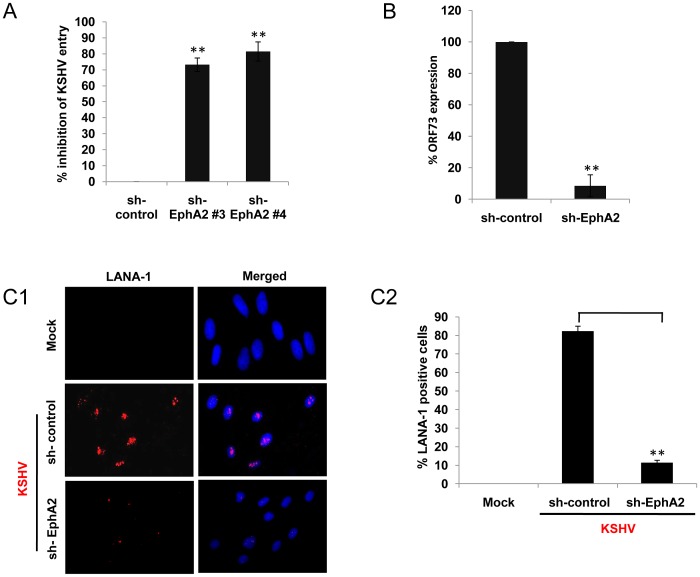
Effect of EphA2 knockdown on KSHV entry and infection in HFF cells.(A) Control or different EphA2 shRNA-transduced HFF cells were infected with KSHV (30 DNA copies/cell) for 10 min at 37°C. After washing, total DNA was isolated and virus entry was determined by real-time DNA PCR for KSHV ORF73 gene. Results are presented as percentage of inhibition of KSHV DNA internalization by sh-EphA2 transduced compared to control shRNA transduced HFF cells incubated with virus. Data shown are means ± SD (n = 3; ** statistical significance, P<0.01). (B) Control or sh-EphA2 transduced (no 4) HFF cells were infected with KSHV for 2 h. At 48 h.p.i., cells were harvested for RNA isolation and viral gene expression was determined by real-time RT-PCR with KSHV ORF73 gene specific primers. Data represented are means ± SD (n = 3; P<0.01). (C1 and C2) Control or sh-EphA2 transduced HFF cells were either mock infected or infected with KSHV (30 DNA copies/cell) for 2 h at 37°C, washed and cultured in complete media for another 46 h. After washing, cells were fixed and processed for immunofluorescence using rabbit anti-LANA-1 antibody. Representative images are shown. The percentage of cells showing punctate LANA -1 dots is represented in the graphical plot. A minimum of 3 fields having at least 20 cells were chosen. Error bars show means ± SD.